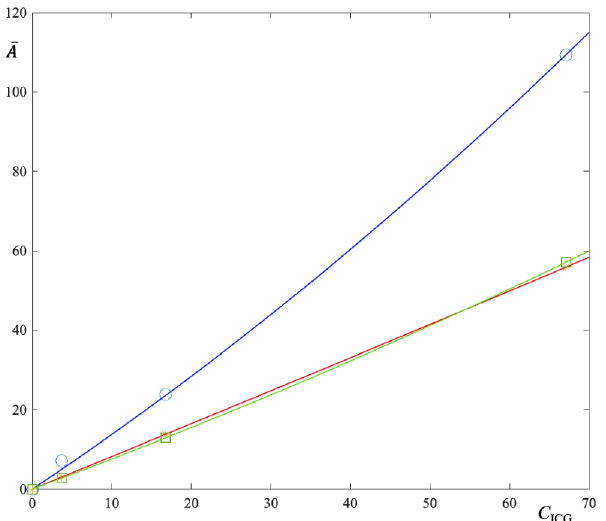
Figure 7. Integral absorbance as a function of ICG concentration for three fixed LAP concentrations (1%, 2% and 3%). Numerical analysis reveals that experimental data are best-fitted by a polynomial of degree 2. This confirm the prediction of Equation